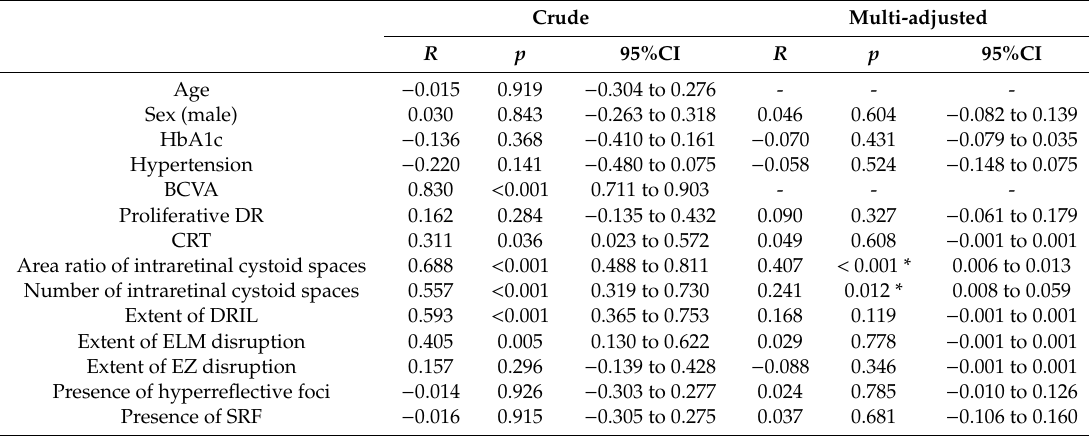
Table 2. Association between BCVA at 12 months and baseline